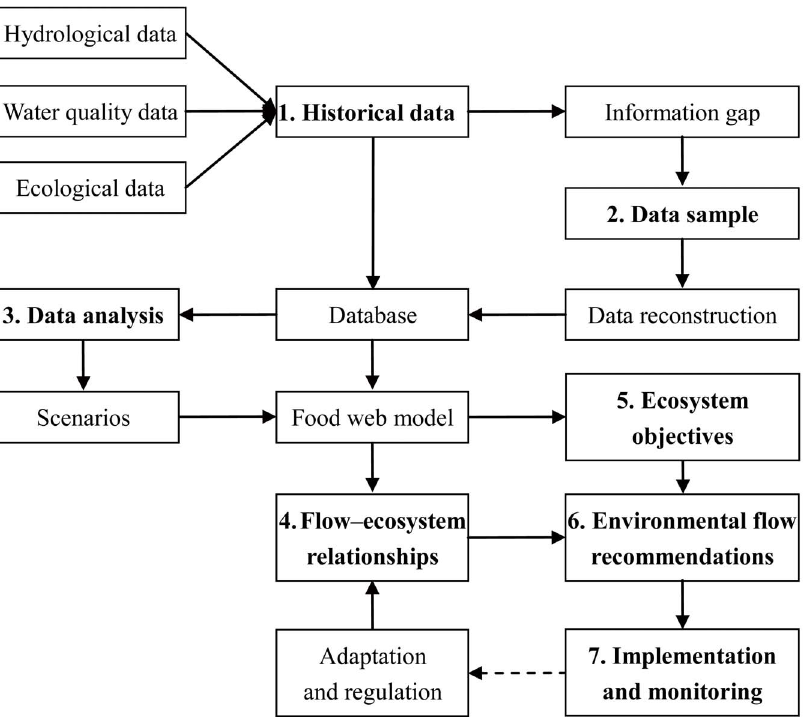
Figure 3. Framework for environmental flow assessment based on food web dynamics. The framework comprises seven steps: (1) collection of historical data; (2) data sampling; (3) data analysis; (4) flow alteration–ecological response relationships; (5) protection objectives; (6) flow recommendations; and (7) implementation.